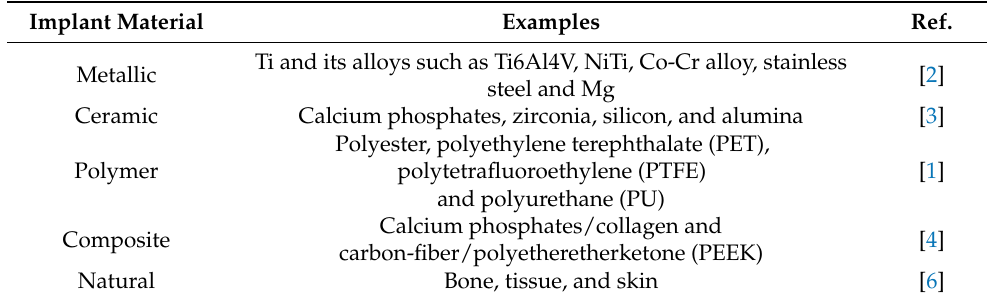
Table 1. Some examples of implants based on their constituent